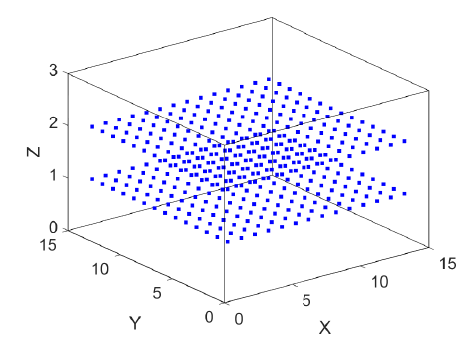
Figure 6. Reference point distribution figure.